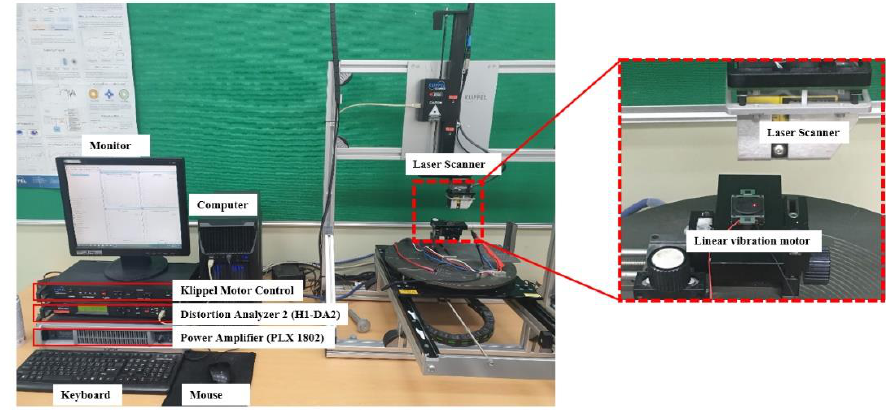
Figure 4. Set-up of Klippel equipment.